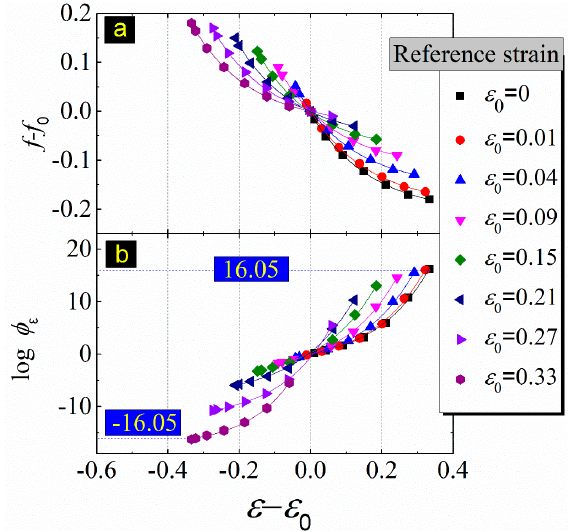
Figure 13. ( a ) Strain expansion coefficients (the slope of colored curves); ( b ) strain shift factors at reference strain of 0.01, 0.04, 0.09, 0.15, 0.21, 0.27, and 0.33.